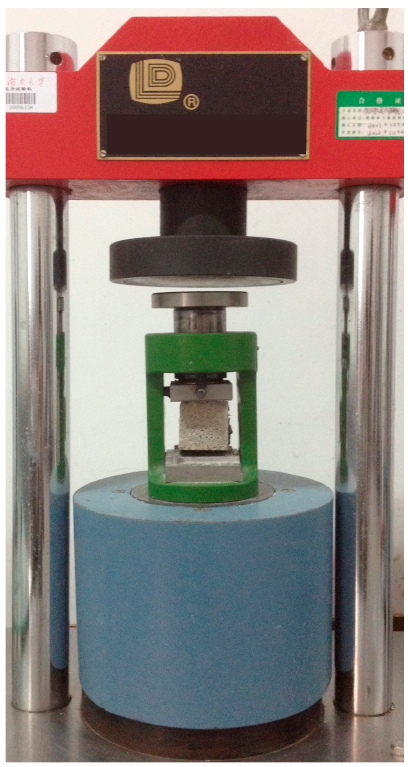
Figure 5. Compressive strength test.